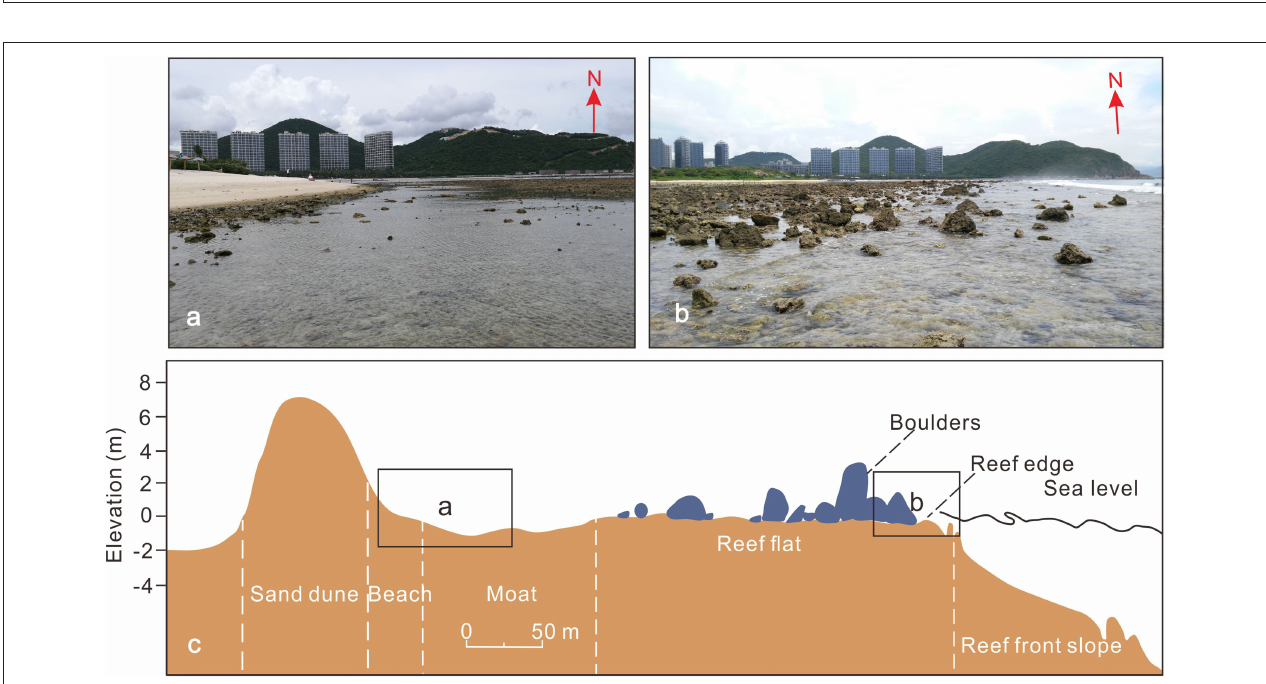
FIGURE 2 | The spatial distribution and morphology of the boulders: (a) Google Earth map showing the distribution and weight of boulders at the XDH study site; (b) photographs showing the coral boulder field; and (c) the largest boulder at the site.